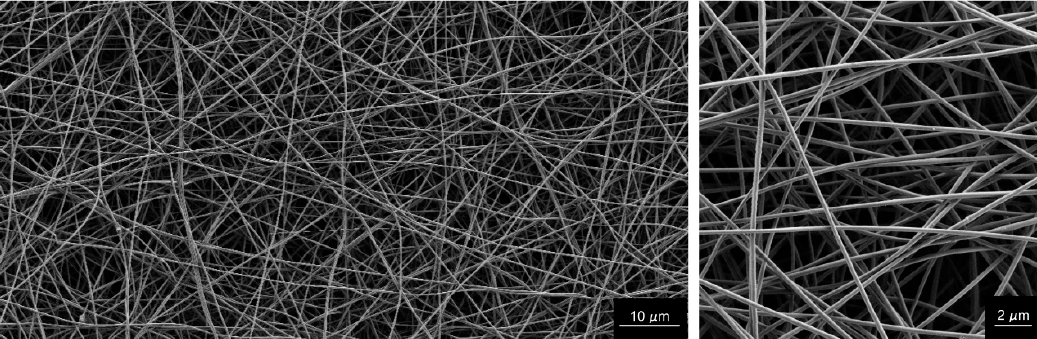
Figure 11. Representative scanning electron microscopy images of nanofibers obtained from the electrospinning of the exemplary polymer-blend solution, with a composition of 4 MDa PEO, 3.5% total polymer concentration, and PEO proportion in the dry polymer mix of 10%. Magnification, 2500 × (left); 15,000 × (right).